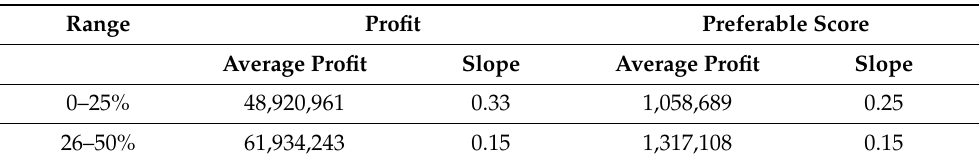
Table 13. Slope of the change in profit and preference score when using different levels of number of tourists, changed from the current